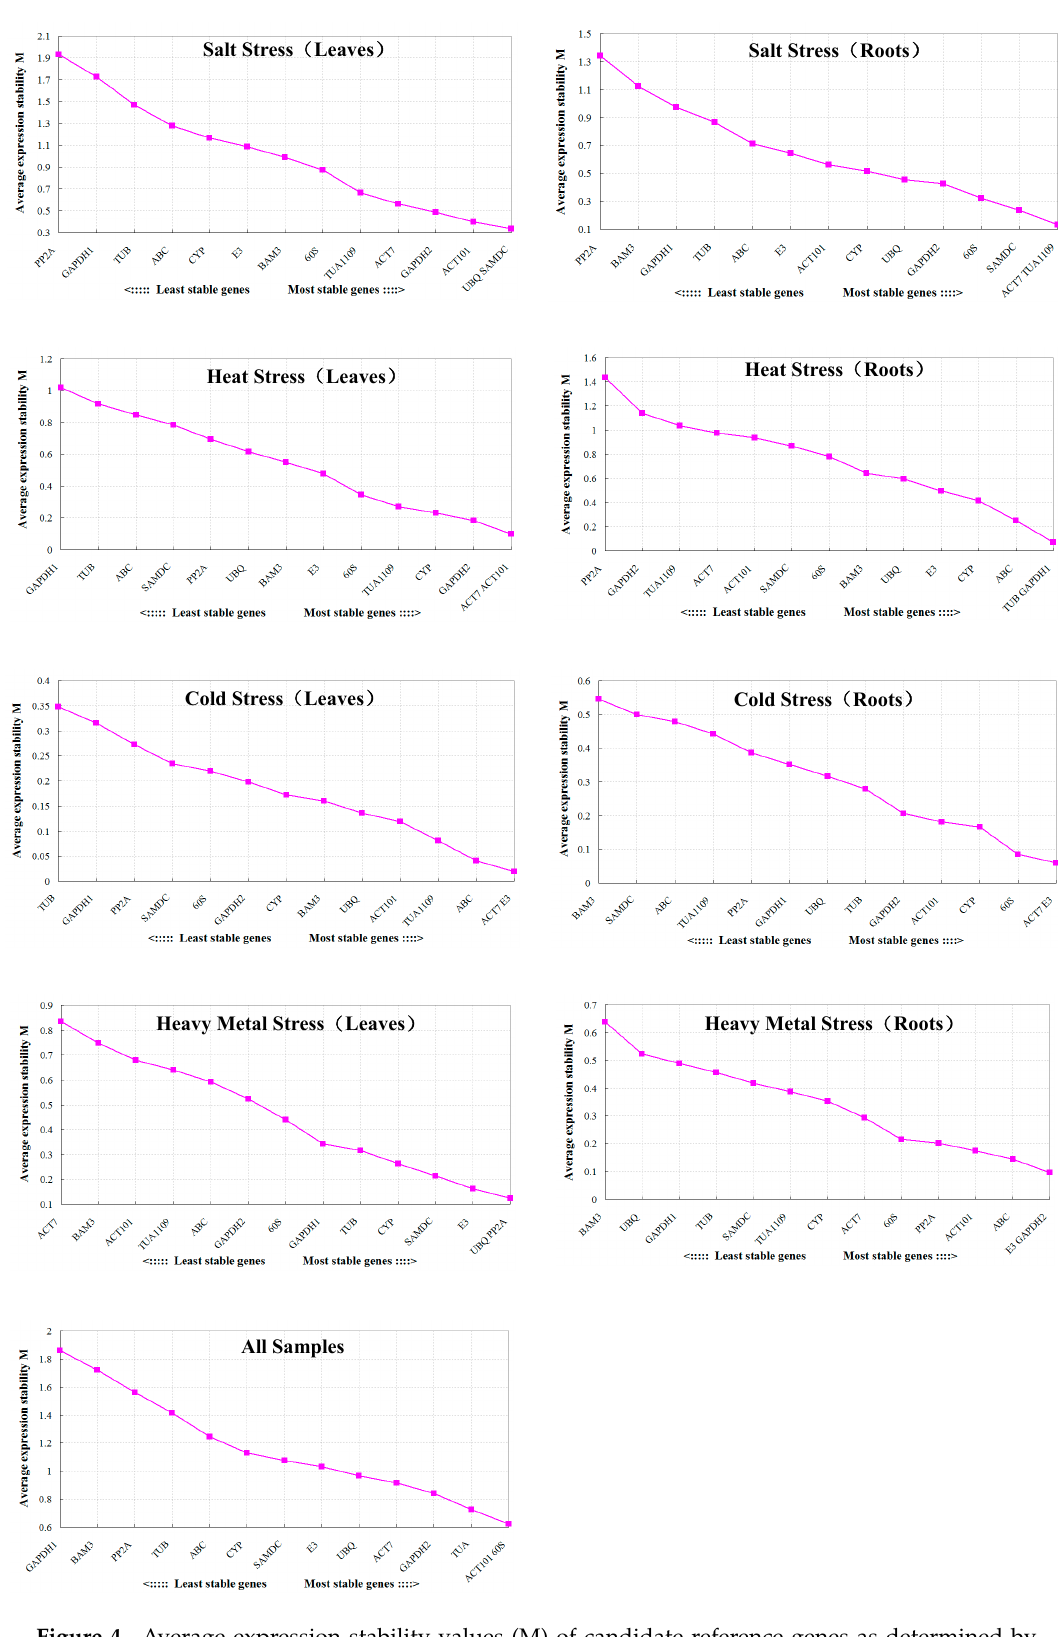
Figure 4. Average expression stability values (M) of candidate reference genes as determined by GeNorm analysis.